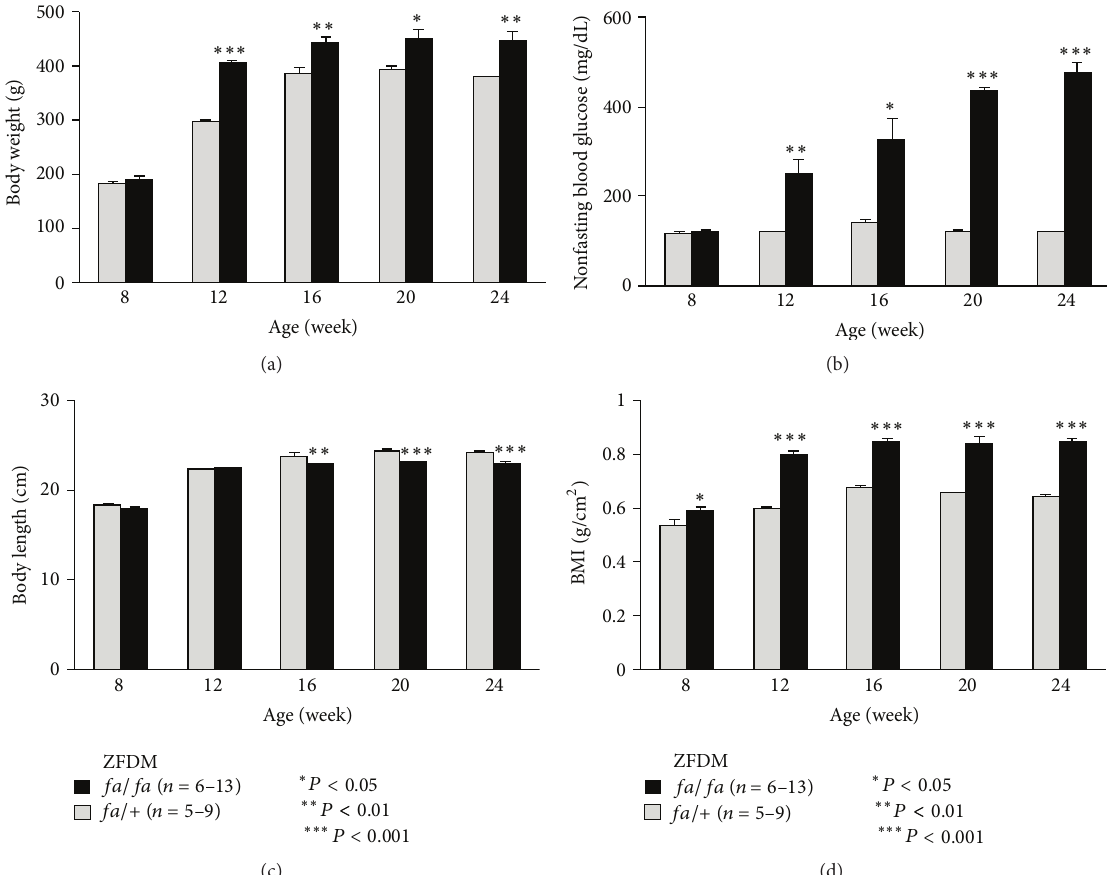
Figure 3: Cross-sectional phenotypic characterization of the ZFDM strain. (a) Body weight, (b) nonfasting blood glucose level, (c) Body length, and (d) BMI of fa/fa ( 𝑛 = 6 , 6, 6, 6, and 13 for 8, 12, 16, 20, and 24 weeks of age, resp.) and fa/ + ( 𝑛 = 6 , 6, 5, 5, and 9 for 8, 12, 16, 20, and 24 weeks of age, resp.) male rats in the ZFDM strain. Welch’s t test was used for comparisons between fa/fa and fa/ +